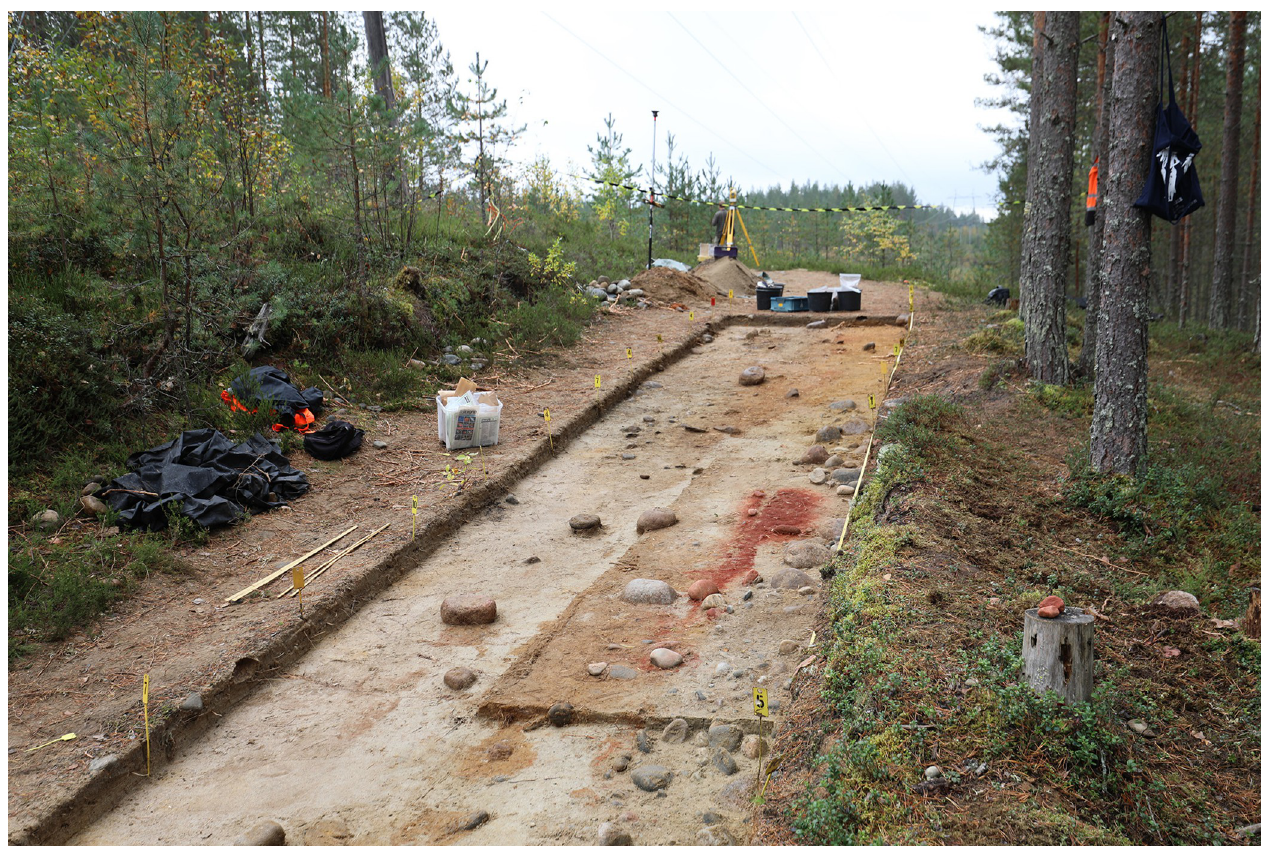
Fig 2. Excavation area towards SE. Photo: Kristiina